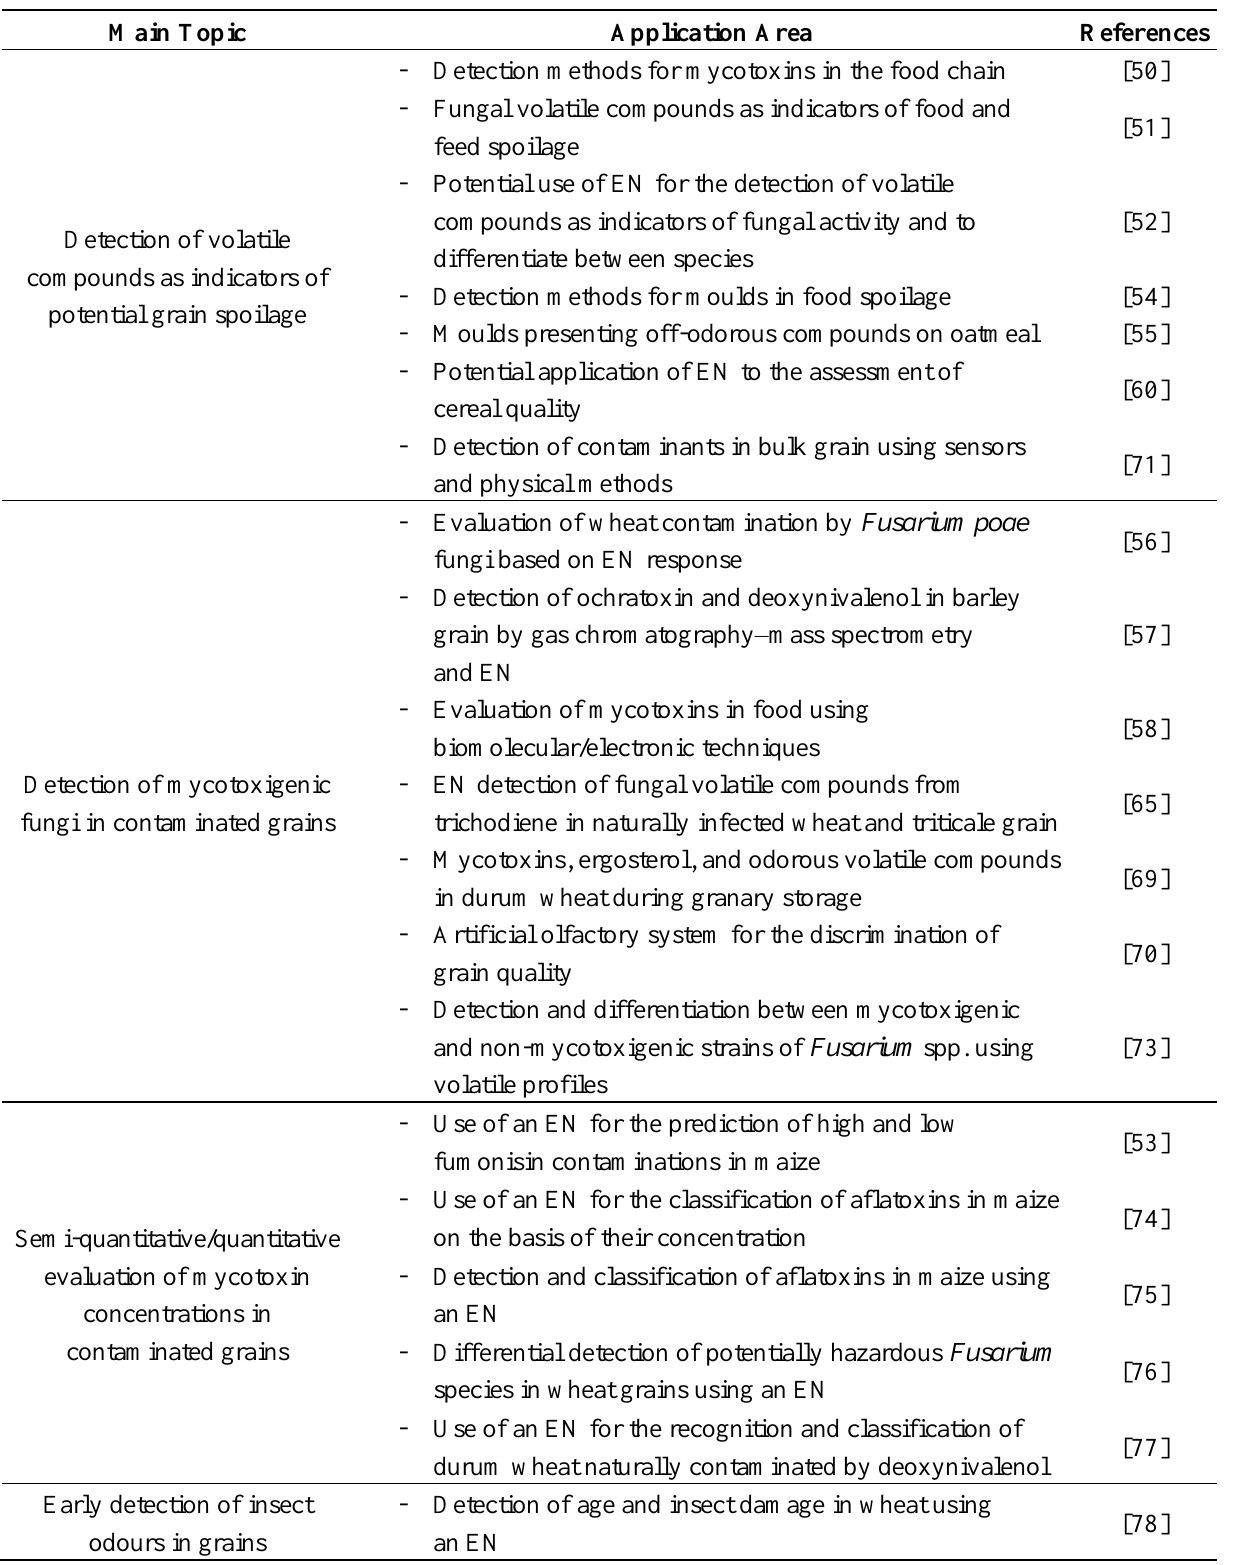
Table 2. The applications of EOSs to investigations of the causes of cereal damage. Main